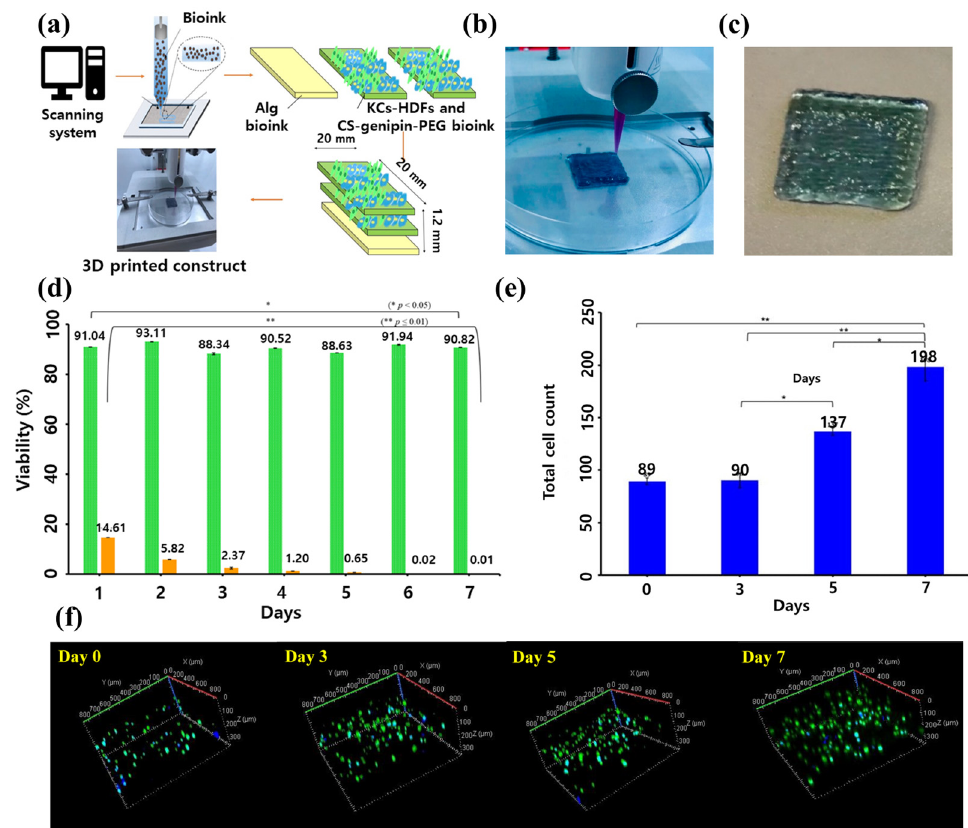
Figure 4. CS-genipin-PEG bioink laden with human KCs and HDFs for skin bioprinting. ( a ) Schematic diagram of the 3D printing process and the fabricated skin constructs. Digital image on ( b ) 3D printing process and ( c ) printed skin constructs. ( d ) MTT assay on the bioprinted skin constructs. The CS-genipin-PEG is green, and TritonX-100 (positive control) is orange. The cell viability was assessed by % of negative control (untreated). ( e ) Total cell count on the printed constructs during 7 days of culture and ( f ) 3D CLSM images. The asterisks (* and **) refer to significant differences (* = p < 0.05; ** = p ≤ 0.01). The data were reproduced from Ref [47]. Copyright 2020 MDPI.